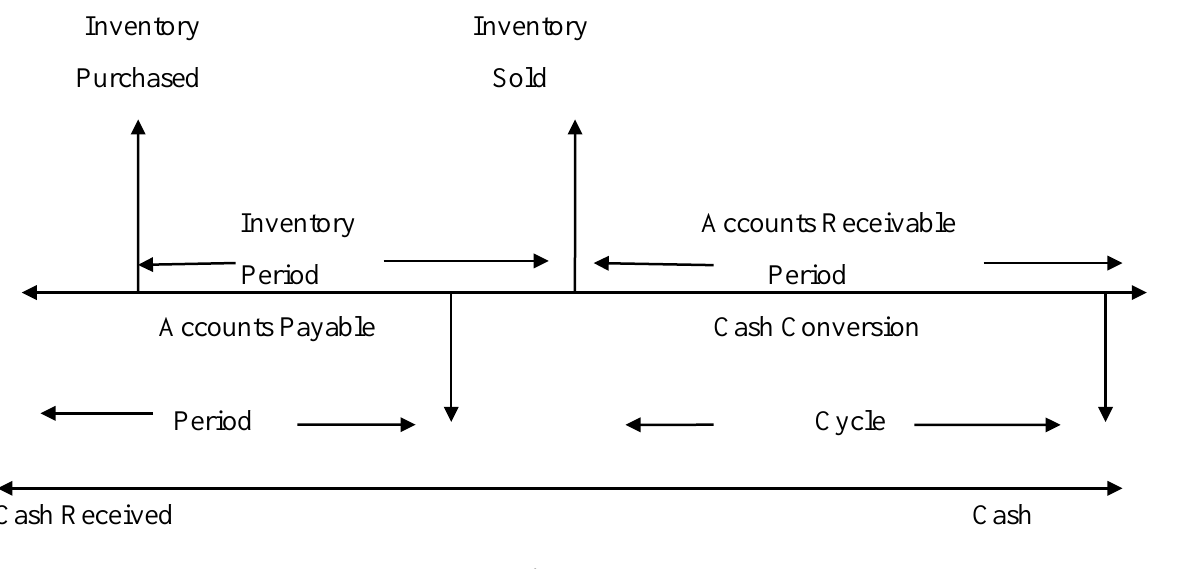
Fig. 1. Operating